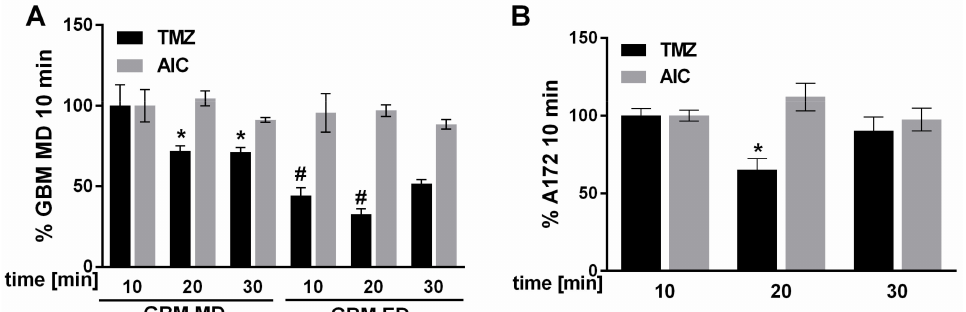
Figure 6. MS analysis of parent drug TMZ and its 5-aminoimidazole-4-carboxamide (AIC) metabolite in primary glioblastoma cells, isolated using enzymatic method (ED) and mechanic method (MD) from the GBM (A) and in stabilized cell line A-172 (B) , used for comparison. The data are expressed as percentage of TMZ or AIC inside the GBM-MD, GBM-ED, and A-172 cells per mg of protein and amount was determined by LC-MS analysis after 10, 20, and 30 min treatment. Measurements were performed in two independent experiments. * p < 0.05 20 and 30 min intervals vs 10 min interval; # p < 0.05 ED vs.